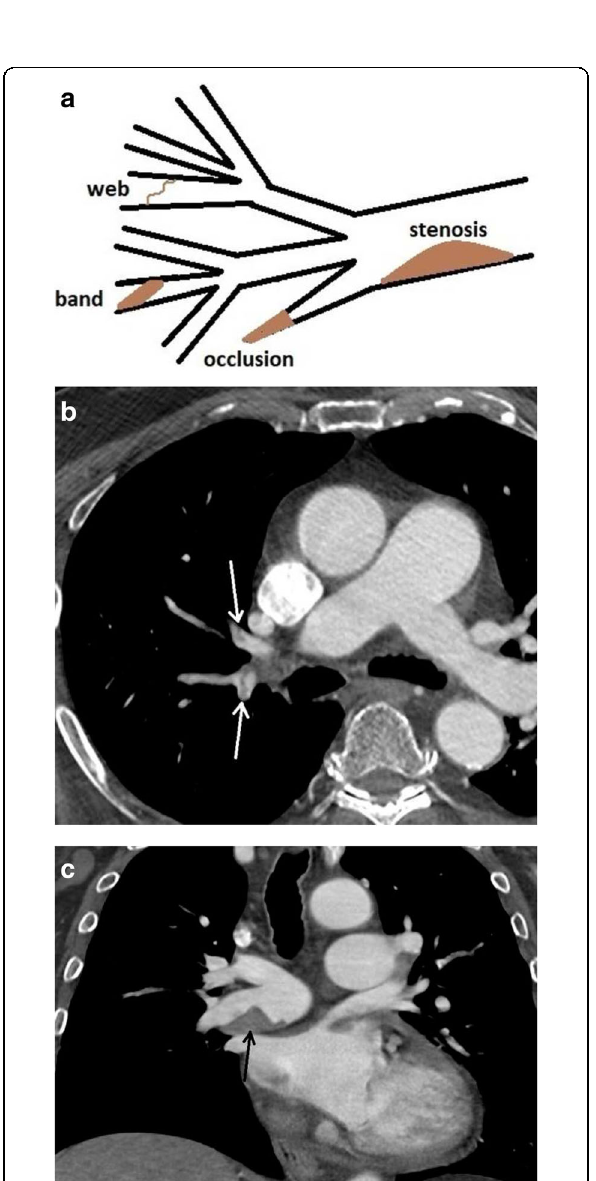
Fig. 20 Configurations in CTEPH. a Figure demonstrating findings of CTEPH including stenosis, web, band, and occlusion. b CTA axial image of web/band (white arrows). c CTA axial image demonstrates eccentric thrombus narrowing the lumen of the right main pulmonary artery (black